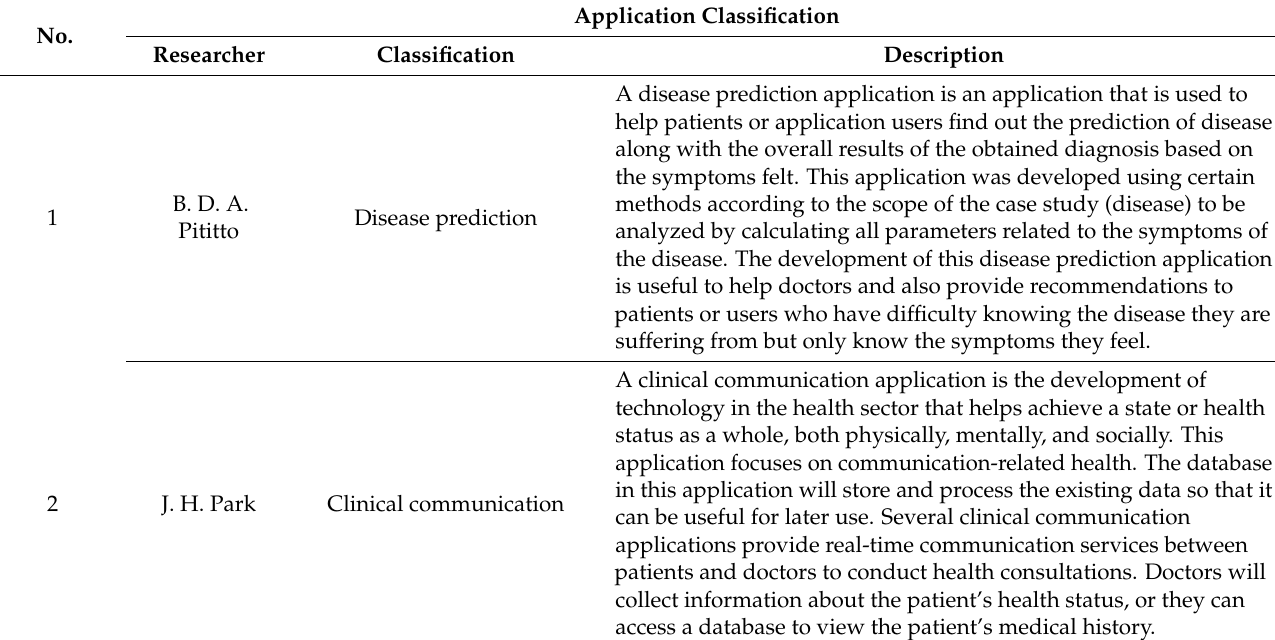
Table 3. Application Classification in